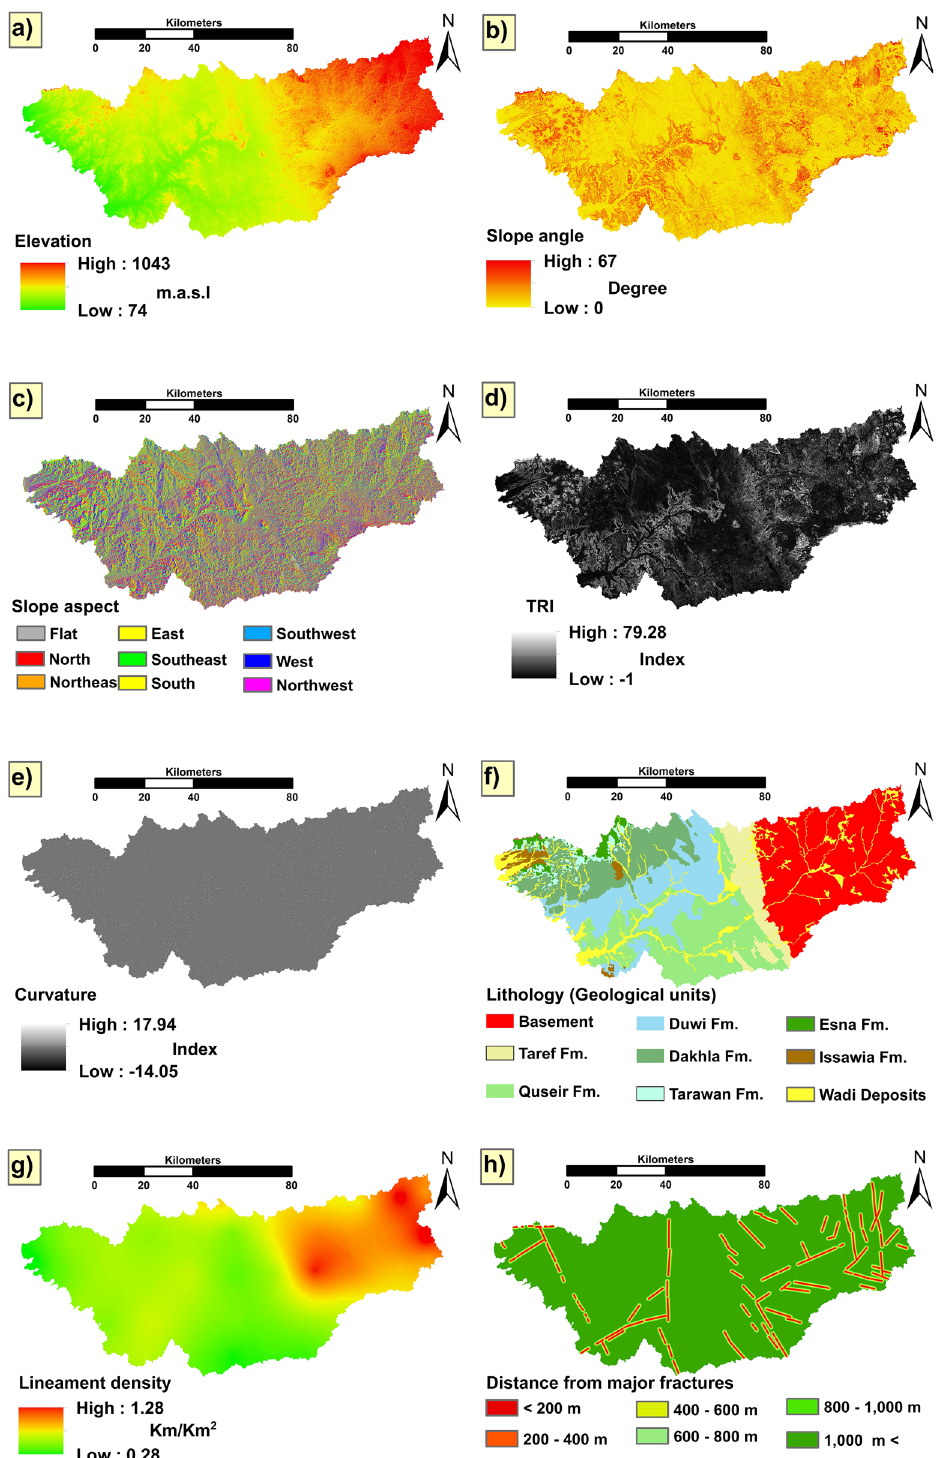
Fig. 4 Effective features creation for GWPM: a elevation; b slope angle; c slope aspect; d TRI; e curvature; f lithology; g lineament density; h distance from major